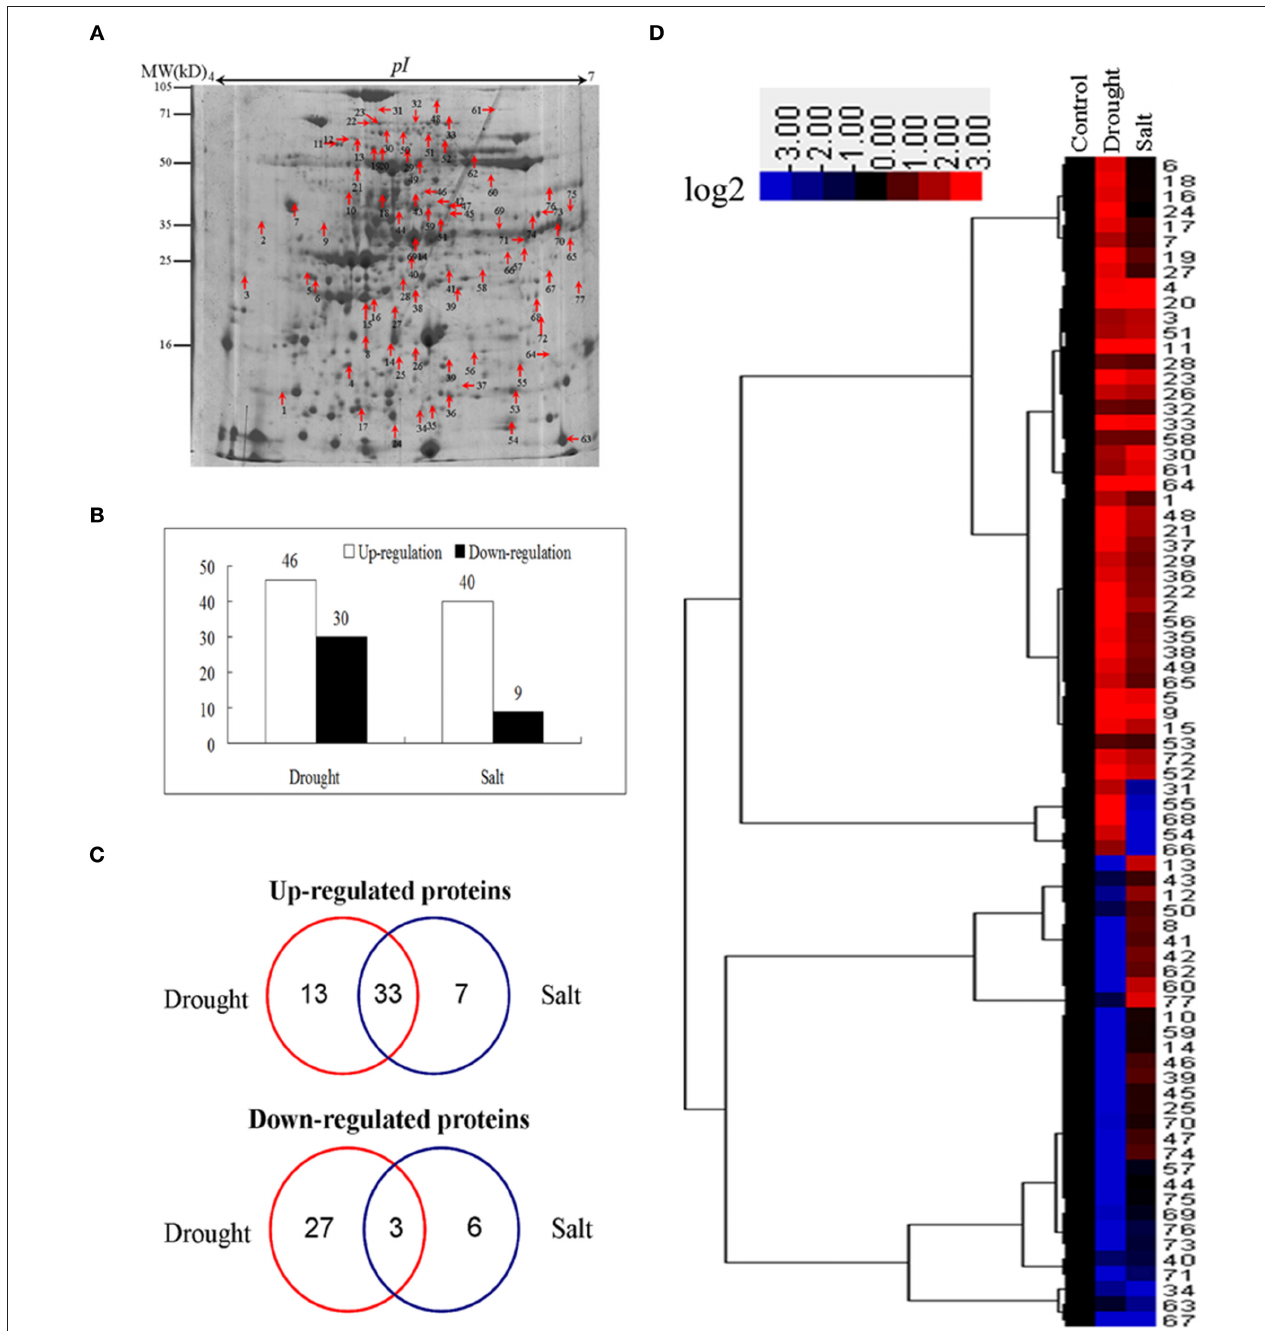
FIGURE 3 | Cluster analysis and comparative distribution of co-regulated proteins by drought and salt treatments. (A) A sketch map to show proteome patterns of bermudagrass in responses to drought and salt. The protein spots induced at least two folds by drought and salt were marked with arrows as shown. Proteins were separated in the first dimension on the IPG strip (pH 4 − 7), and in the second dimension on 12.5% SDS-PAGE. (B) The number of proteins up and down regulated by drought and salt treatments. (C) Hierarchical cluster analysis of fold change of coregulated proteins by drought and salt treatments. Resulting tree figure was displayed using the software package and Java Treeview. (D) Venn diagram showing the number and of proteins that overlapped among three types of drought and salt.